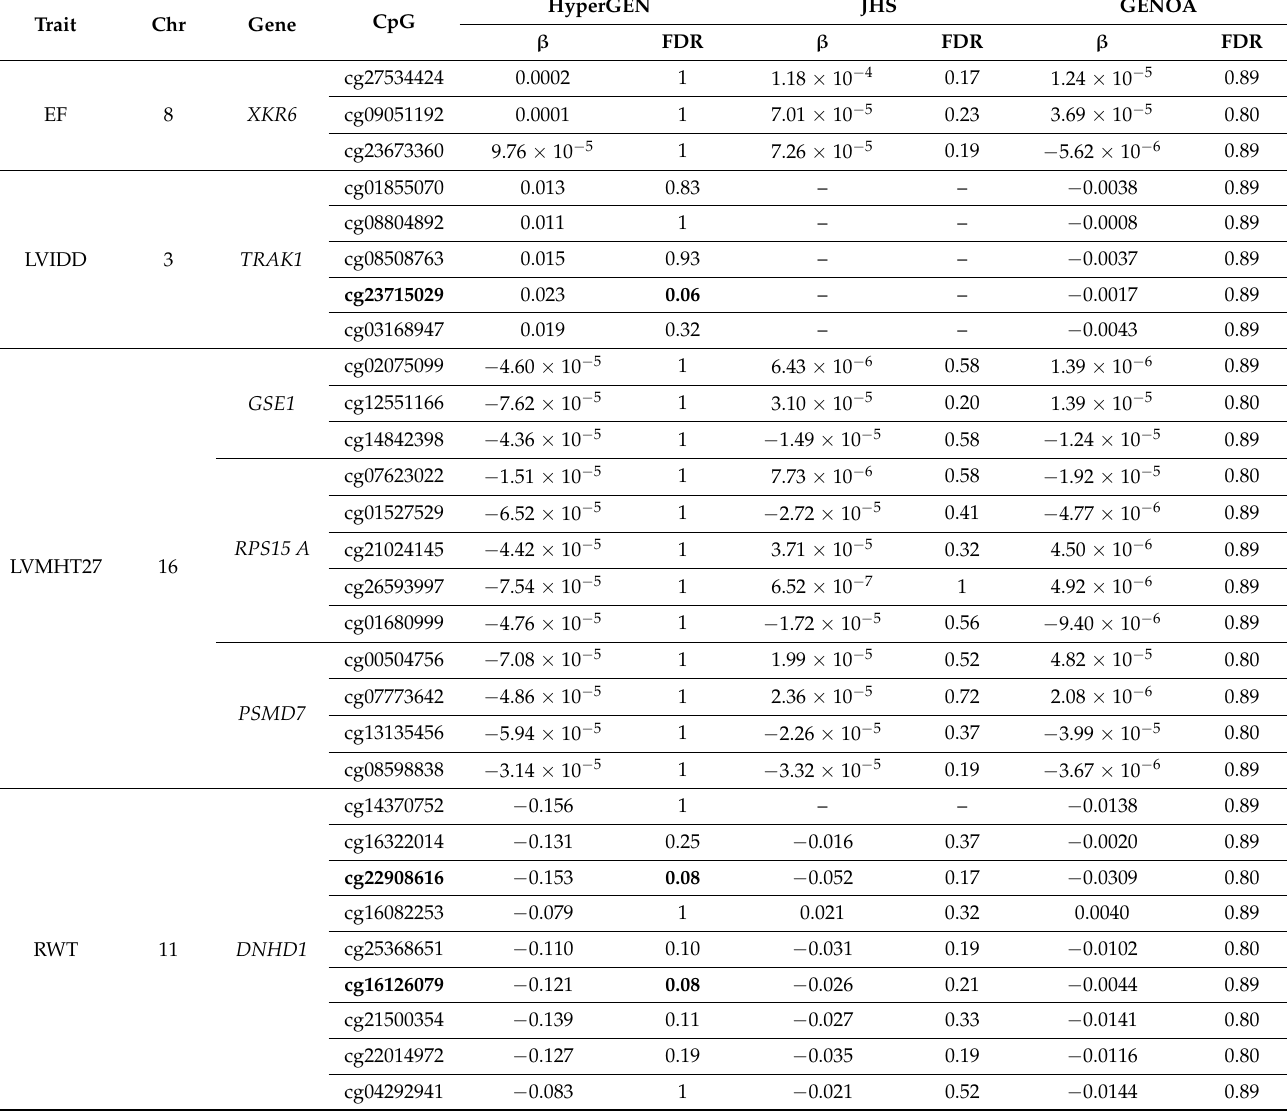
Table 3. CpG associations LV traits within significant DMRs in